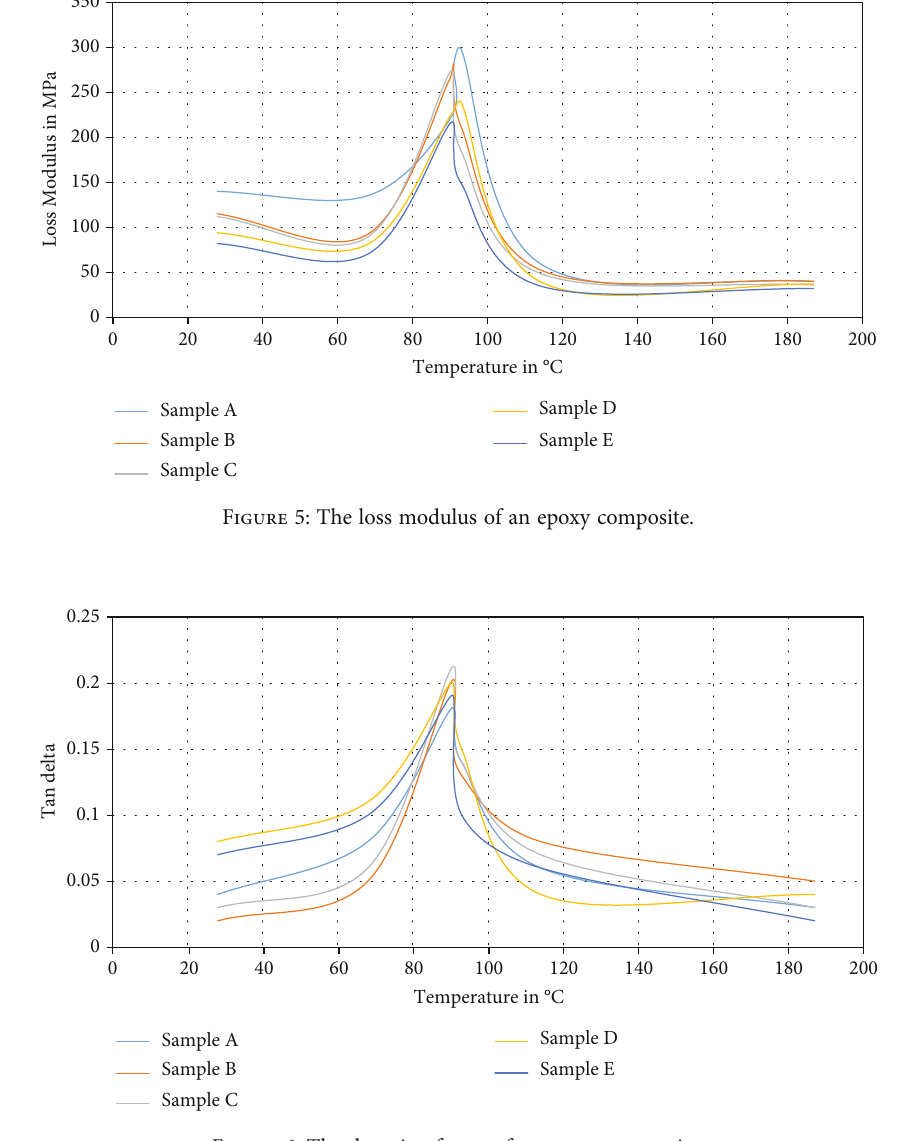
Figure 6: The damping factor of an epoxy